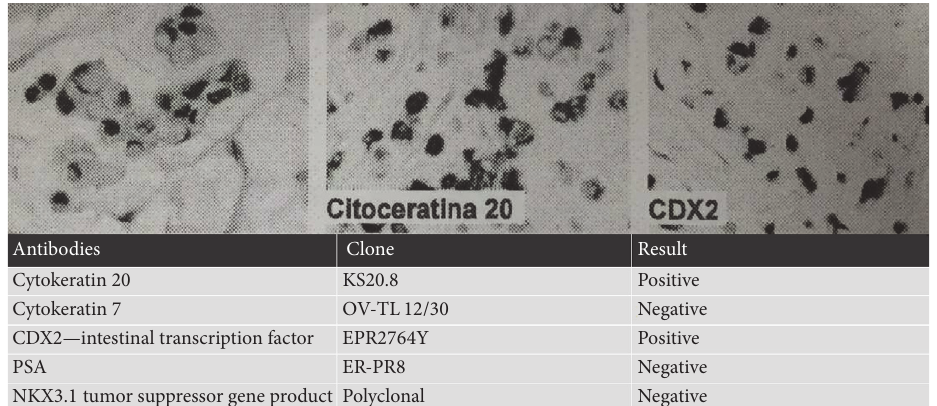
Figure 1: Immunohistochemical examination showing positivity for CK20 and CDX2 and negativity for CK7, PSA, and NKX3.1.